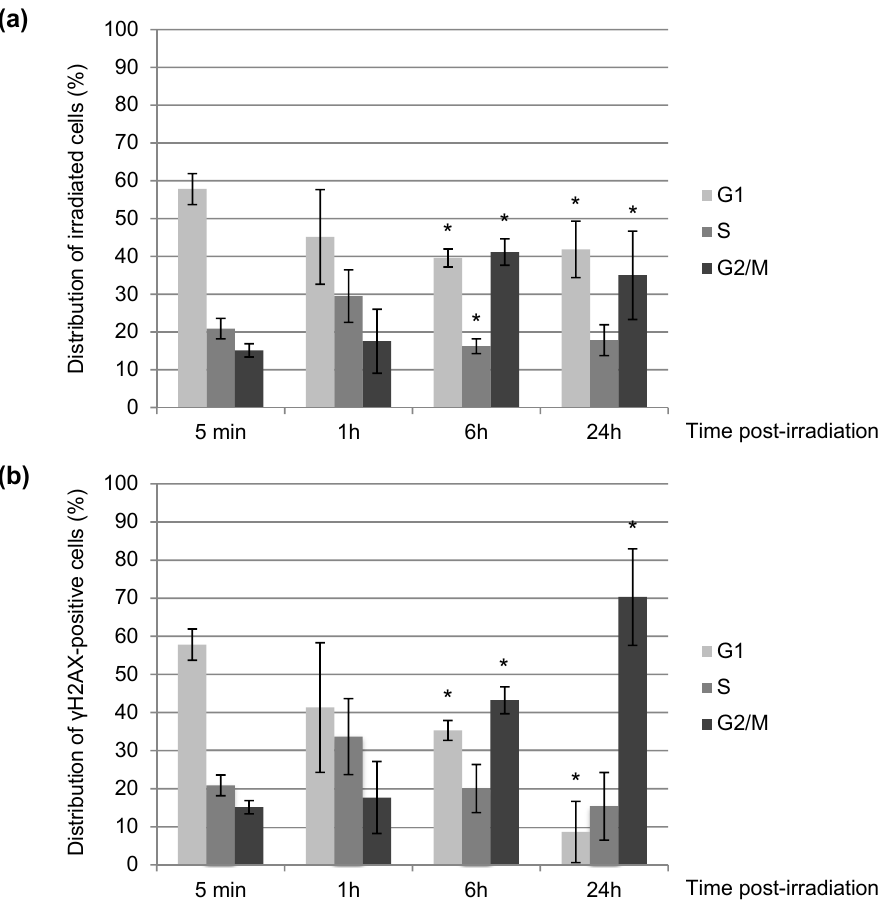
Figure 2. Cell cycle distribution of NIH-3T3 cells upon irradiation with α -particles. We irradiated NIH-3T3 cell nuclei with α -particles distributed in a dotted line, as shown in Figure 1b. At the indicated times after irradiation, we permeabilized cells with CSK + Triton X-100 to remove soluble nuclear components and fixed them. We subsequently performed immunostaining of γ H2AX and DNA staining with DAPI. We monitored the cell cycle status ( a ) of irradiated cells and ( b ) of γ H2AX-positive cells among irradiated cells by immunofluorescence. Each value shown represents the mean of at least three independent irradiations. For each value, we analyzed in total between 80 and 800 cells. The error bars represent the standard error, and the p values are indicated (* p <